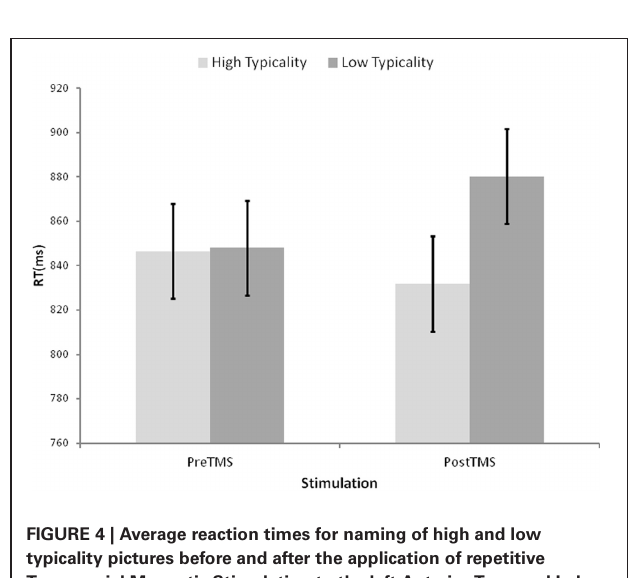
FIGURE 3 | Location of the left Anterior Temporal Lobe site to which repetitive Transcranial Magnetic Stimulation was applied. Crosshairs represent site of stimulation, corresponding to the co-ordinates − 53, 4, − 32 in MNI space.